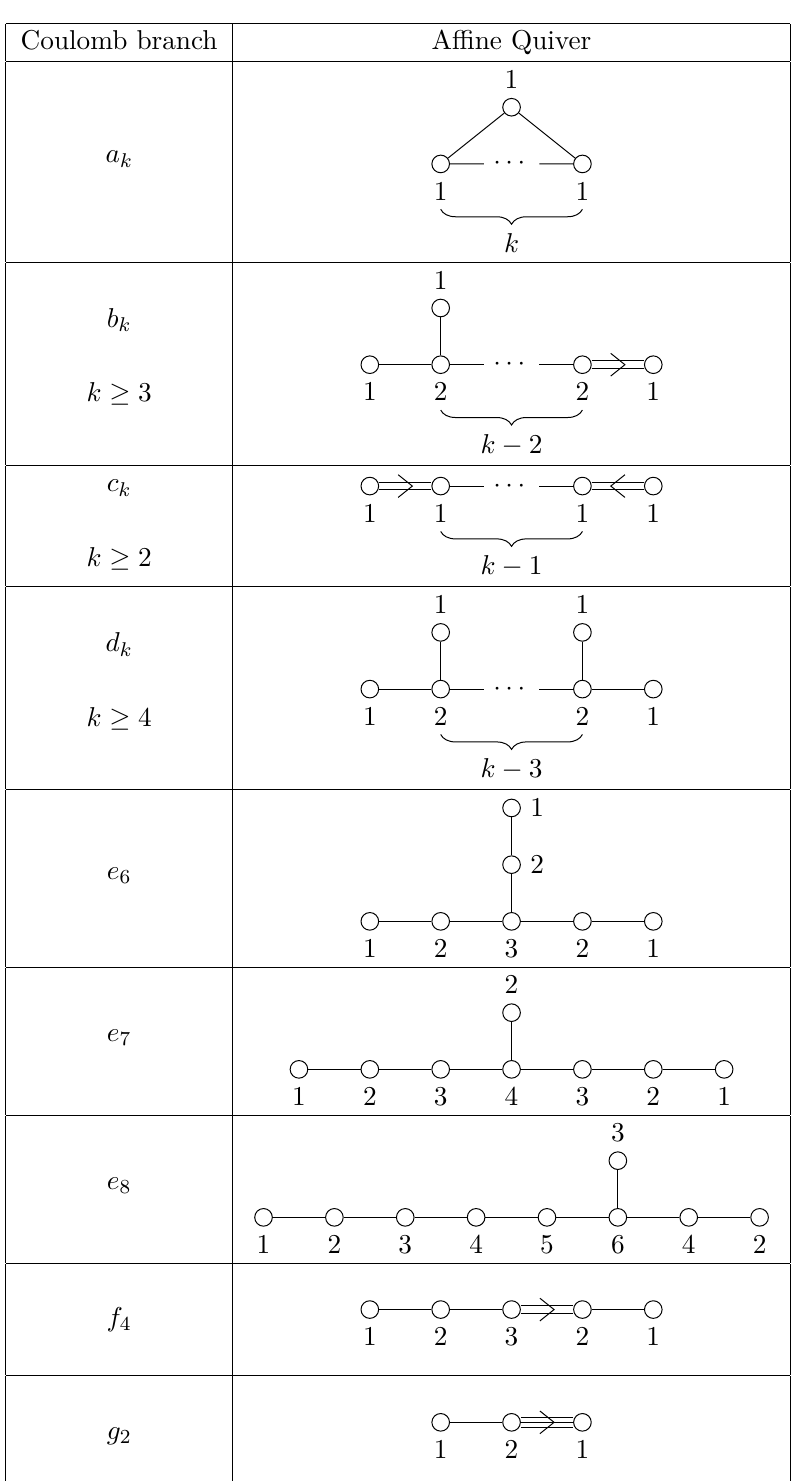
Table 1 . Quivers of the affine Dynkin diagrams. The first column lists the Coulomb branch vari- eties, which are all the minimal nilpotent orbits g in the second column when ungauged on a long node. These quivers will be referred to as “affine g